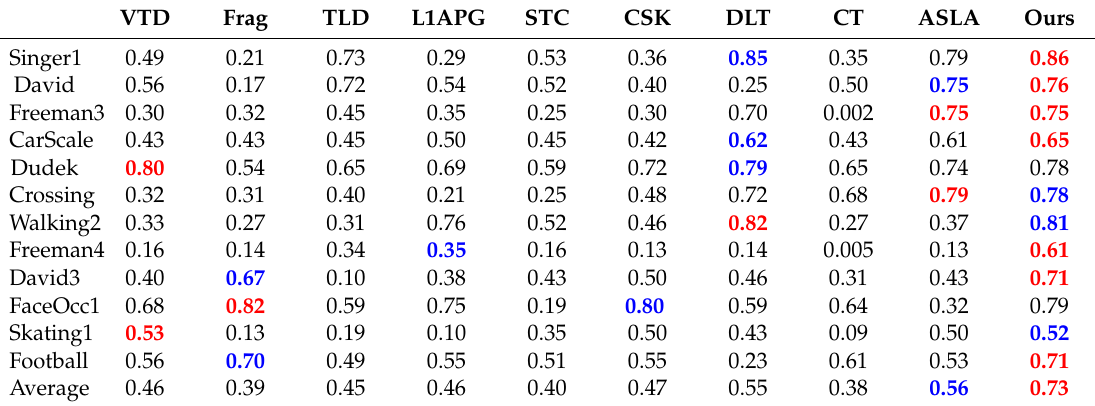
Table 2. Average overlap rate. The best two results are shown in bold red and blue fonts.